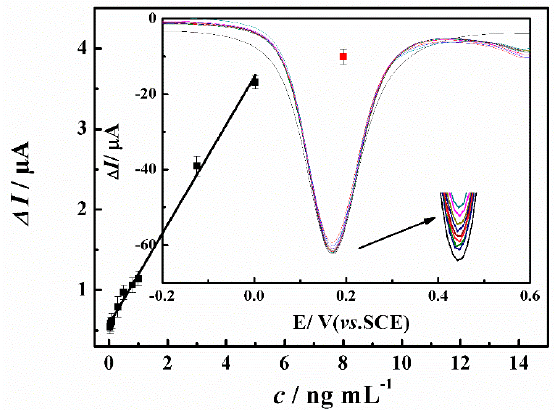
Figure 8. Calibration curve for determining AFP at the imprinted sensor. The inset is the differential pulse voltammograms of K 4 Fe(CN) 6 /K 3 Fe(CN) 6 at the imprinted sensor with different AFP concentrations (0.03, 0.05, 0.1, 0.3, 0.5, 0.8, 1, 3, 5 ng mL − 1 ).